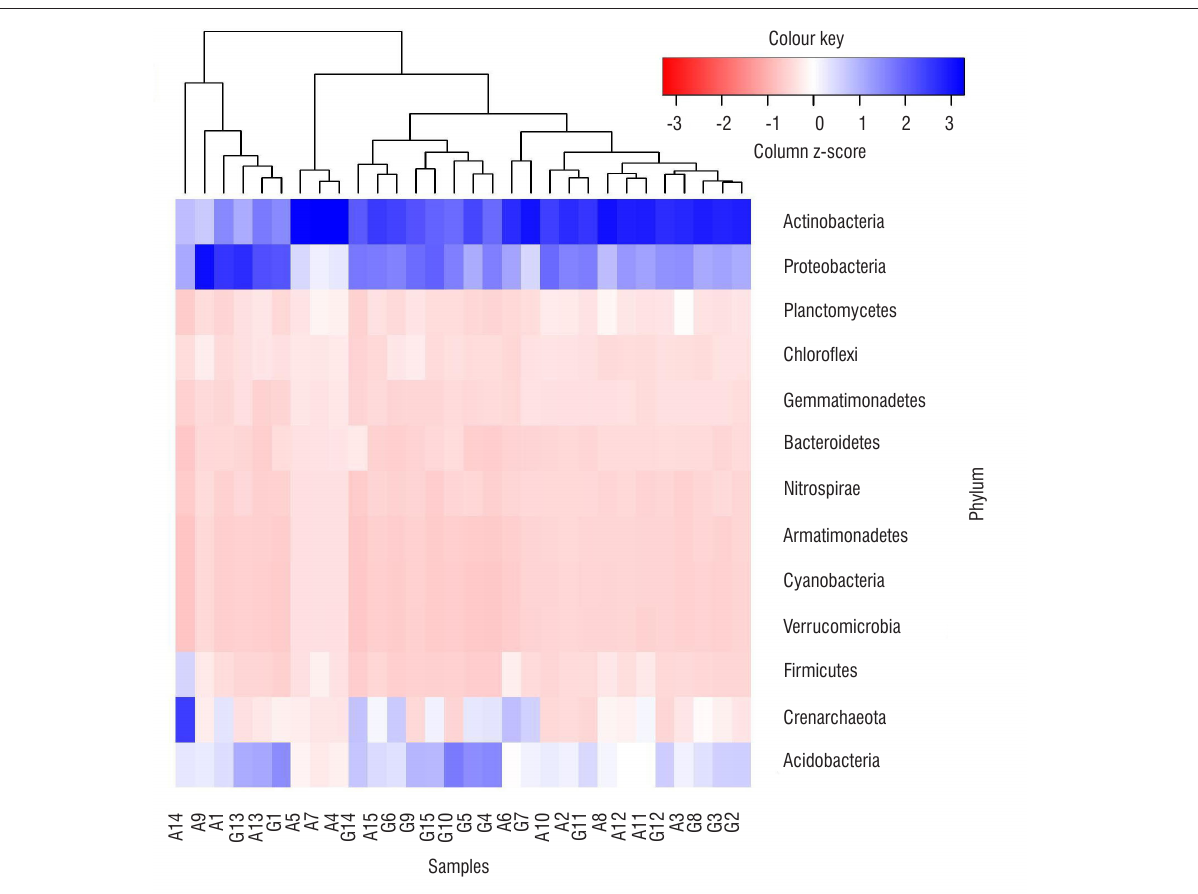
Figure 2: Heatmap displaying the bacteria and archaea phyla detected. Paired-site samples are clustered based on the per cent relative abundance. Each row was scaled so that the mean of each taxonomic group across samples was calculated and coloured by the corresponding z-score of each cell. Sample names starting with A were obtained from agricultural soils while those starting with G were from grassland